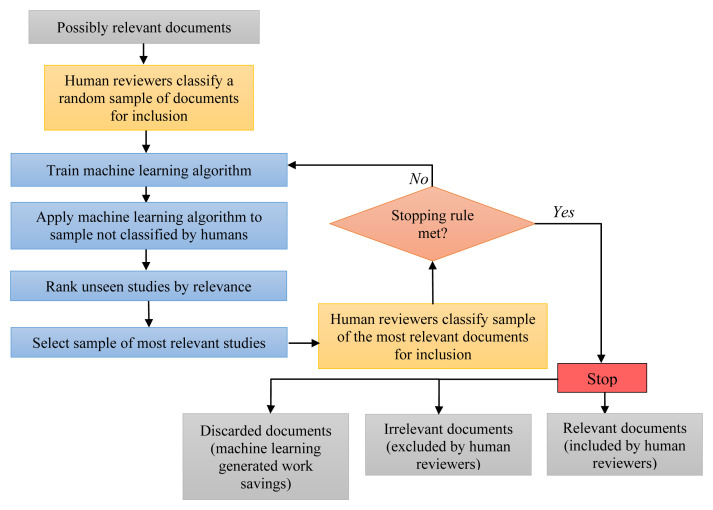
Flowchart illustrating the process of the machine learning assisted abstract screening (
Callaghan & Müller-Hansen, 2019).